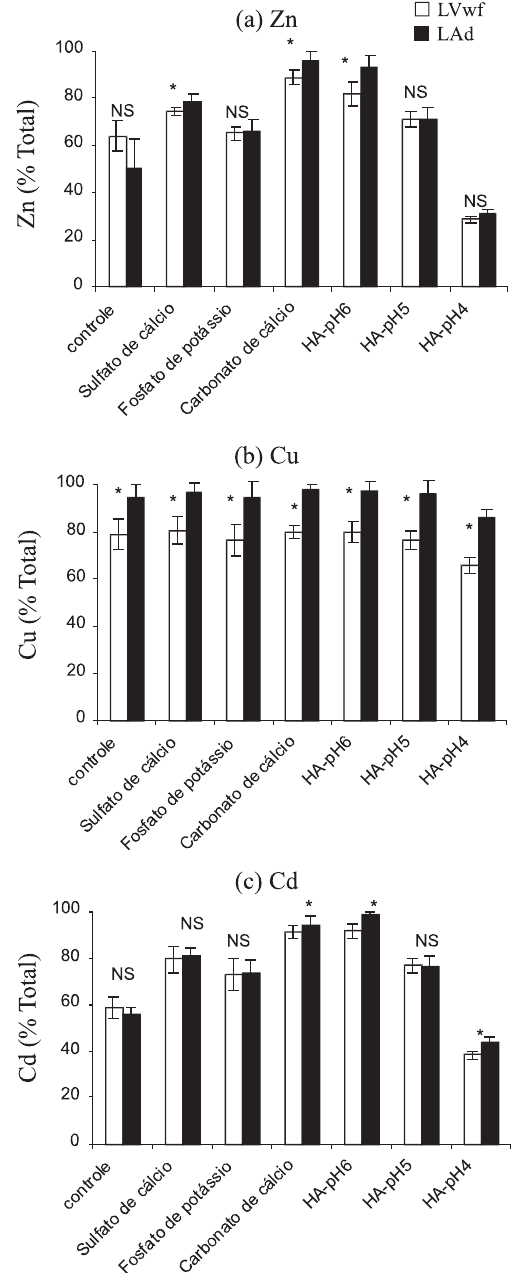
Figura 3. Percentagem dos metais retidos nas amostras de biossólido após o equilíbrio com o Latossolo Vermelho acriférrico (LVwf ) e o Latossolo Amarelo distrófico (LAd). Análises estatísticas referem-se à comparação entre solos, para um mesmo condicionador. * F significativo a 5 %. NS: diferença